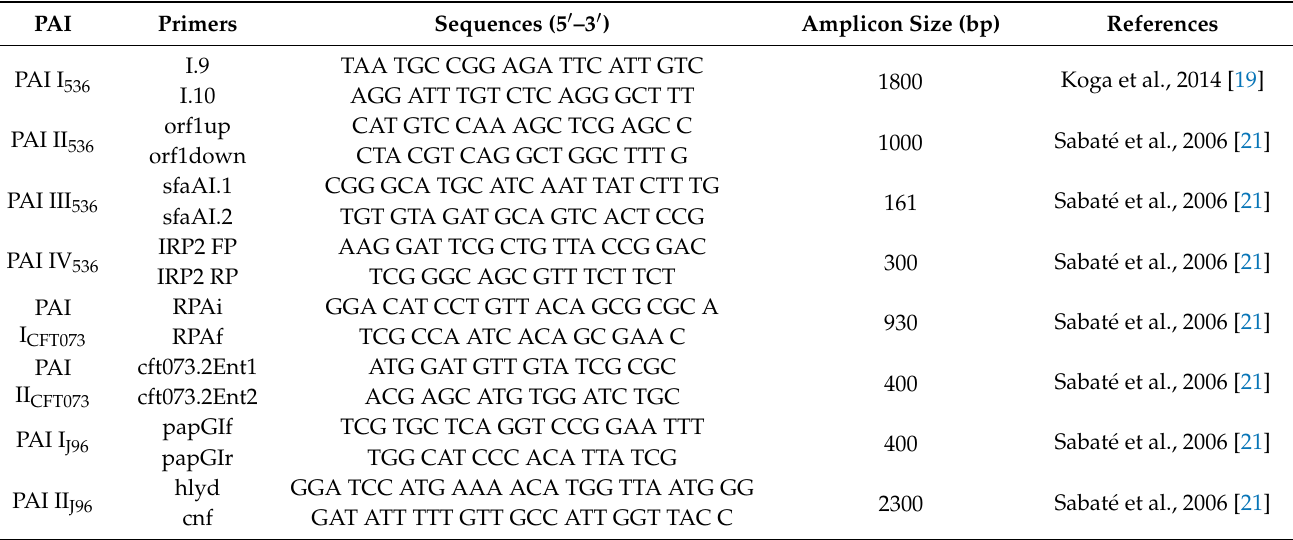
Table 3. Genes encoding PAI markers.